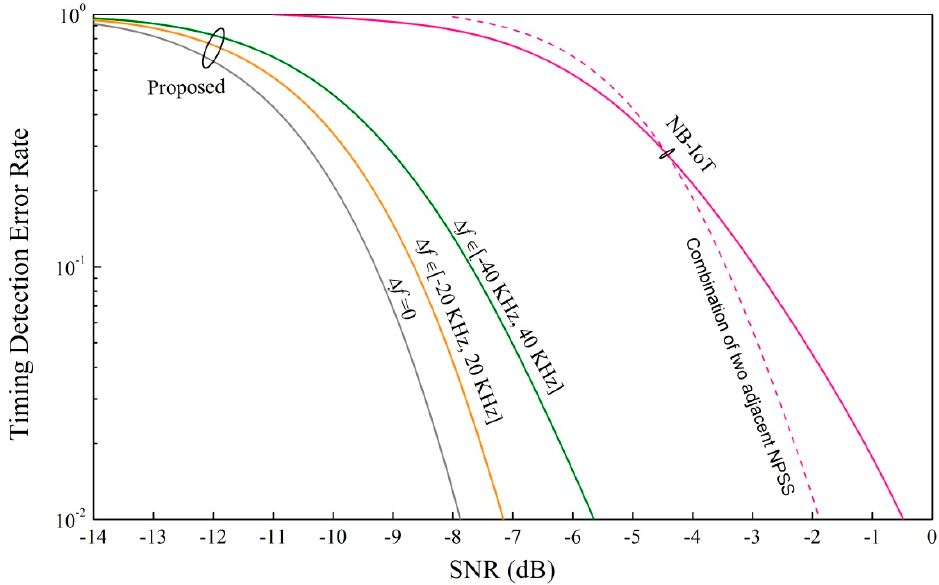
Figure 6. Timing detection error rate of our proposed synchronization signal with different frequency offsets.